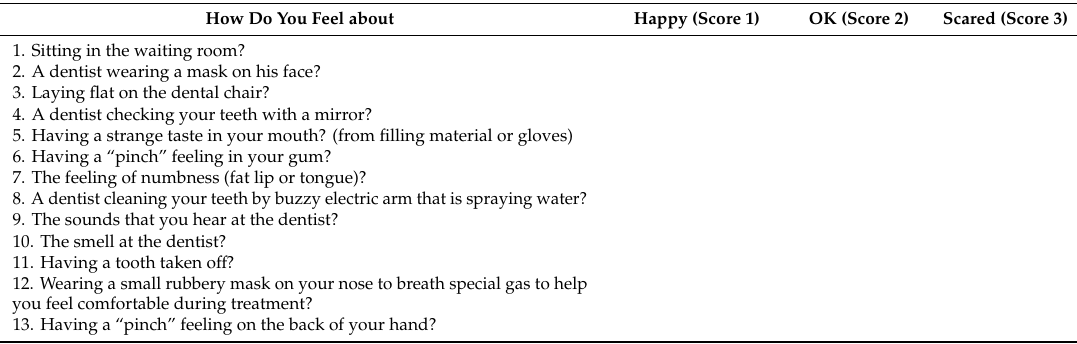
Table 1. The dental part of the Abeer Children Dental Anxiety Scale